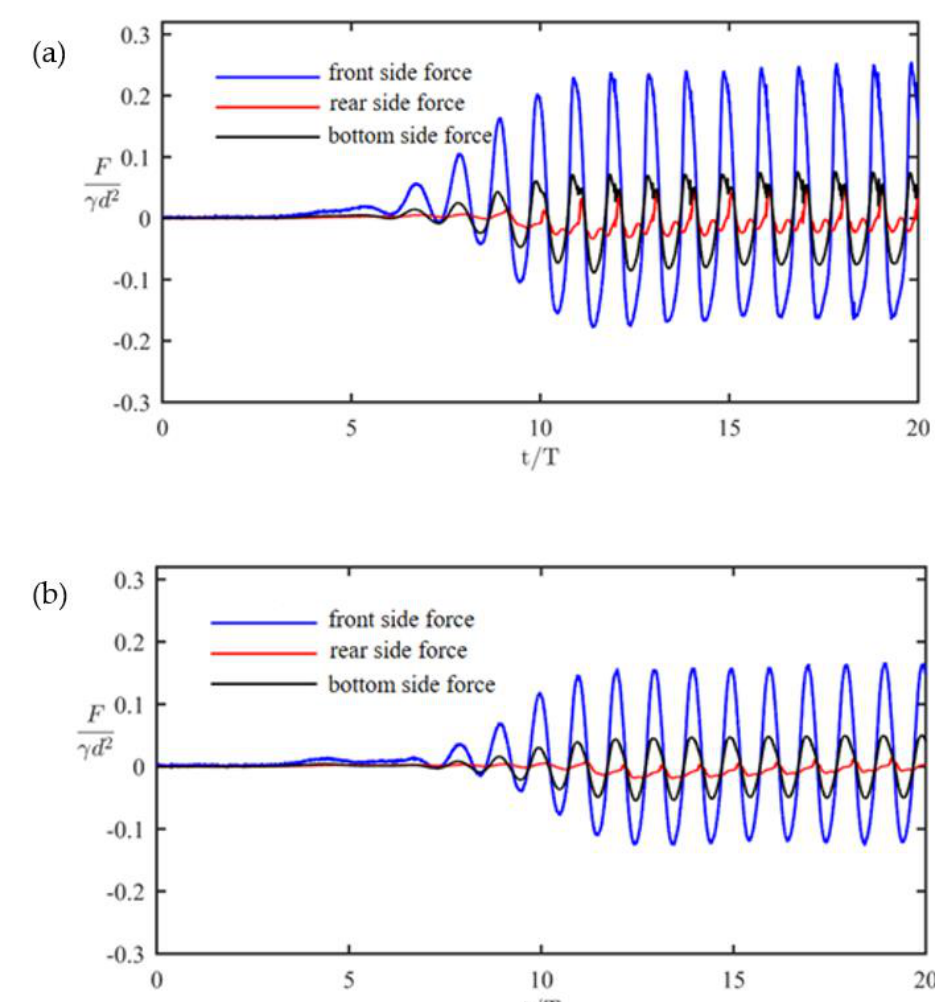
Figure 12. Experimental time series of dimensionless horizontal forces and uplift forces below caisson for wave period of 1.94 s and wave heights of ( a ) 22.54 and ( b ) 12.01 cm.